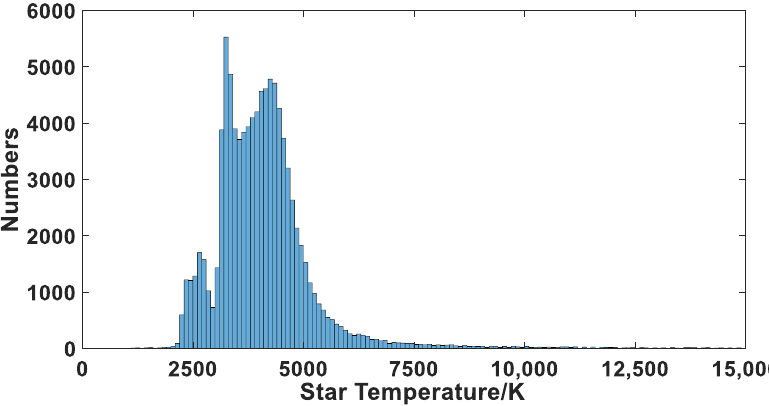
Figure 1. The design flow of All-Time star sensor detection model.